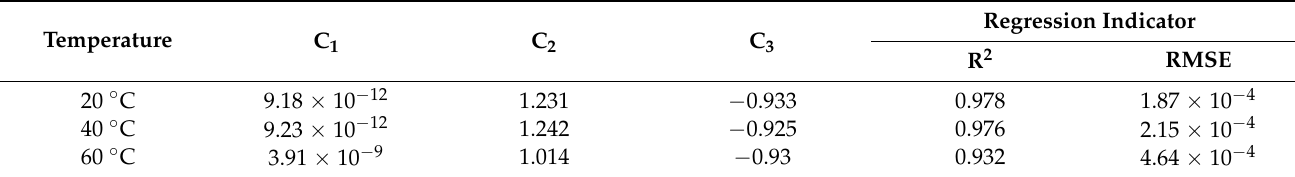
Table 5. Fitting parameters of the modified time hardening model.